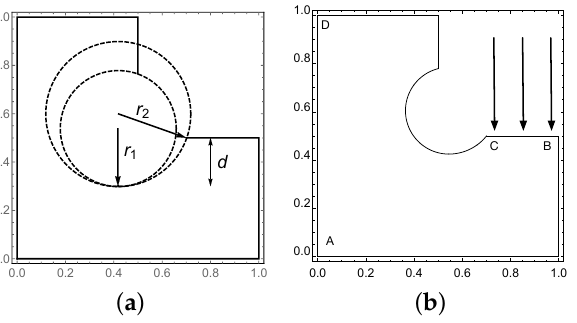
Figure 4. Double fillet configuration. L-shaped domain within a unit square, vertical drop d ∈ [ 1/20,1/10 ] , double filleting with r ∈ [ 3/25,6/25 ] and r ∈ [ 3/20,1/4 ] . The boundary AD at x 2 1 is clamped. Loading is unit traction acting on u 2 in the negative y -direction along the horizontal segment BC at x 2 = 0.5. ( a ) Configuration; ( b ) Chosen